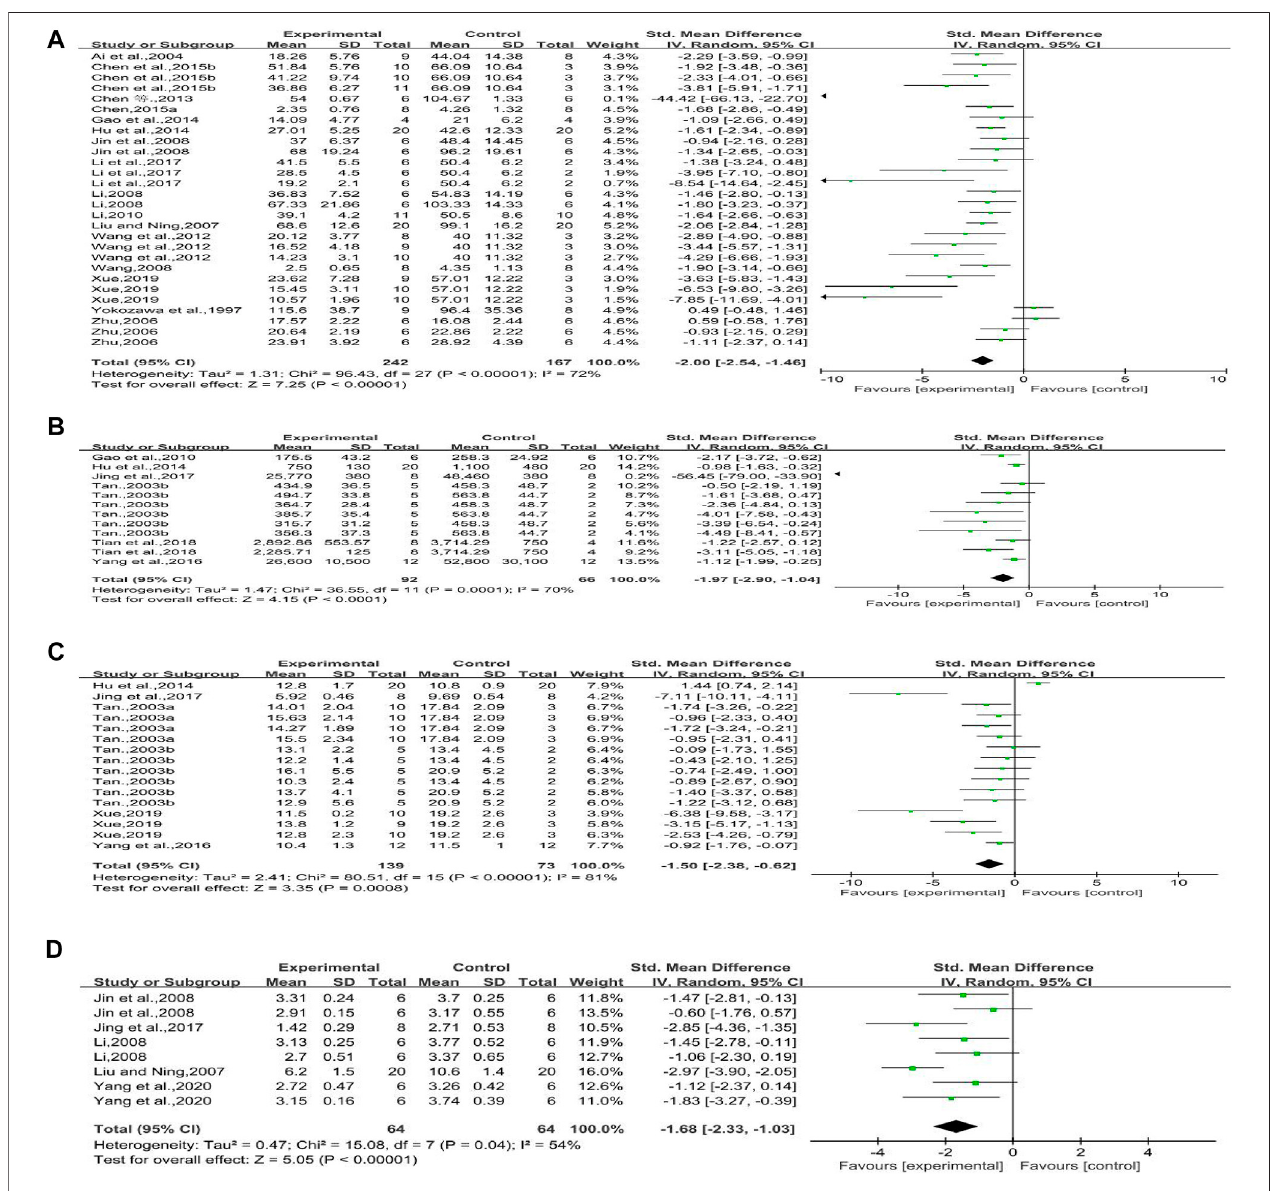
FIGURE 4 | (A) Forest plot of UP, (B) forest plot of UAE, (C) forest plot of KW/BW, and (D) forest plot of TII.